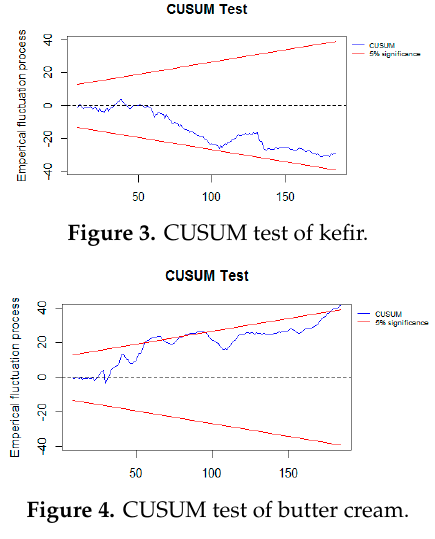
Figure 2. Cumulative sum ( CUSUM) test of butter.